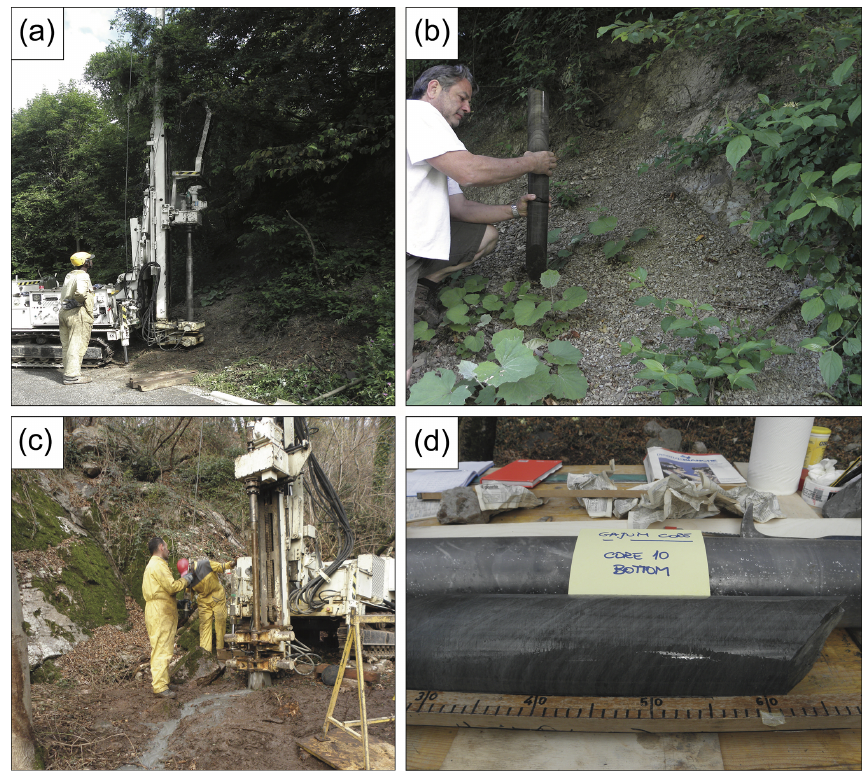
Figure 2. Coring operations and results at Sogno and Gajum sites. (a) Coring Sogno Site 4. (b) Livello a Pesci in the Sogno core compared to the equivalent outcropping lithostratigraphic interval. (c) Coring at Gajum. (d) Black shale interval recovered in core 10 of the Gajum